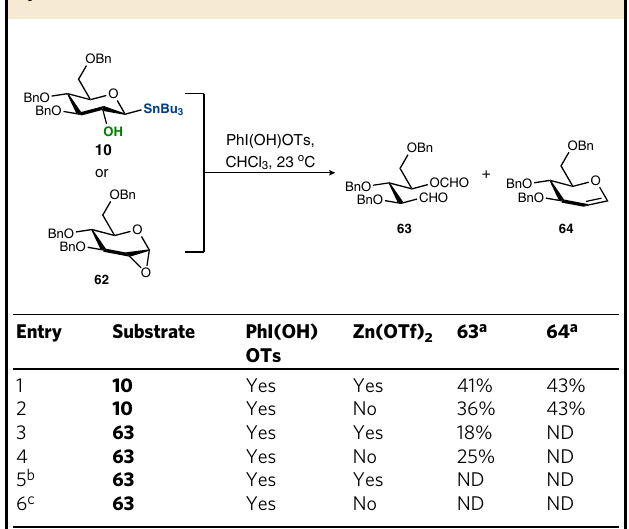
Table 3 Oxidative transformations of D -glucose 10 and epoxide